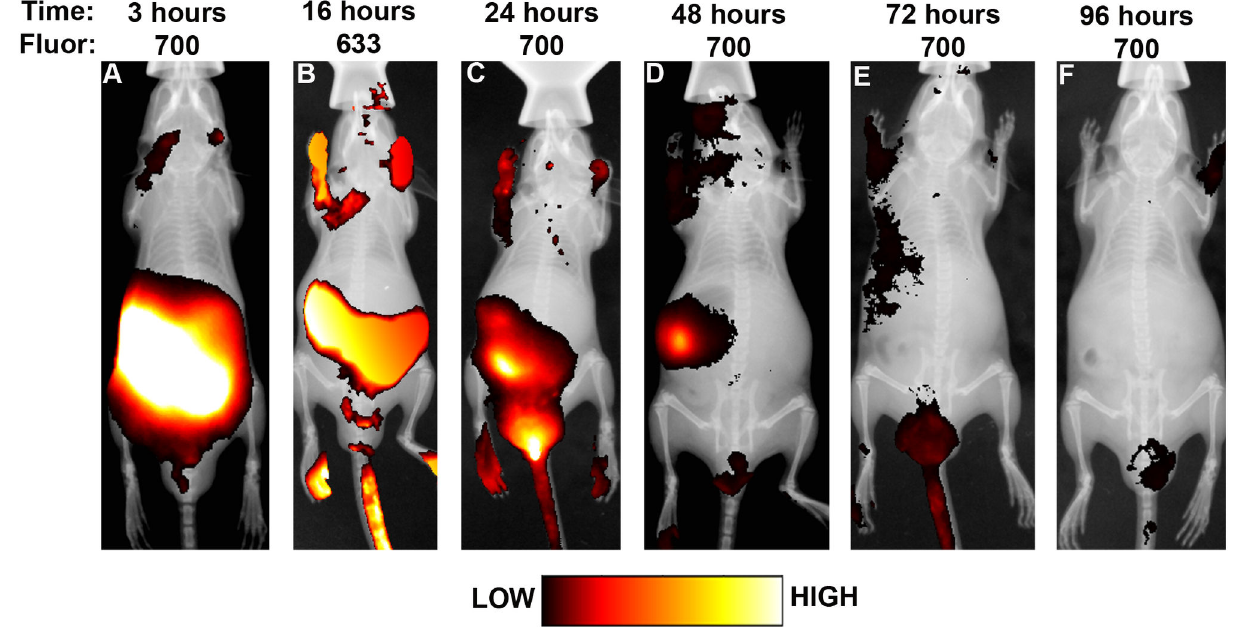
Figure 4. Visualization of labeled ricin in live mice. Fluorescently-labeled ricin was administered intragastrically and mice were viewed after 3 (A), 16 (B), 24 (C), 48 (D), 72 (E), or 96 (F) hours post exposure. Ricin labeled with Alexa Fluor ® 700 (A, C, D, E, F) was imaged at 690 nm and ricin labeled with Alexa Fluor ® 633 (B) was imaged at 620 nm. X-rays were taken of the four sides of each mouse at each time to facilitate localization of the fluorescent signal. Each mouse is representative of three mice per time point, and the experiment was repeated three